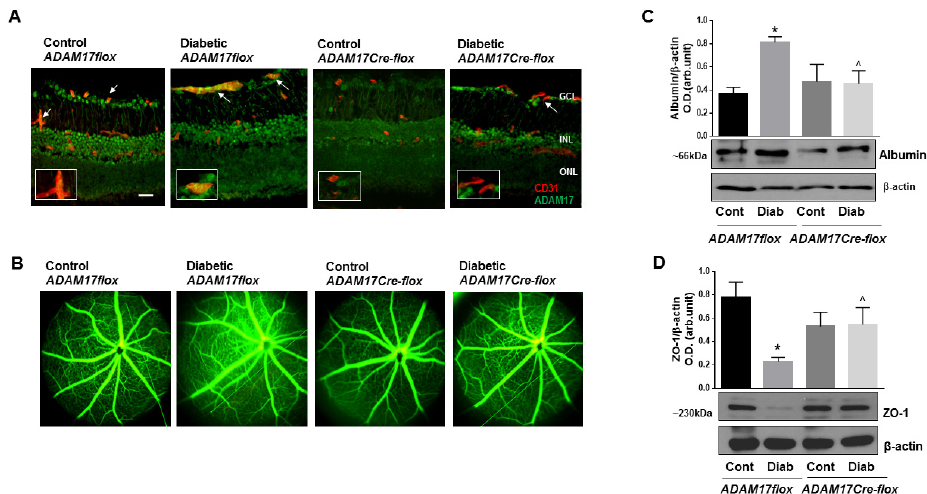
Figure 3. Diabetes-induced retinal vascular leakage is reduced in mice with conditional inactivation of ADAM17 in vascular endothelium. ( A ) Representative images of ADAM17-specific immunoreactivity (green, ADAM17; red, CD31; yellow, merging, white arrows) in retinal cryosections of normoglycemic and diabetic ADAM17Cre-flox and ADAM17flox mice at 10 weeks of diabetes. Inserts are magnified images of representative blood vessels. Scale bar, 50 µ m. ( B ) Fluorescein angiography from control normoglycemic and diabetic ADAM17flox and ADAM17Cre-flox mice. n = 5 in each group. ( C ) Western blot analysis assessing albumin protein levels in retinal extracts of perfused mice from control normoglycemic and diabetic ADAM17flox and ADAM17Cre-flox mice. Data presented as mean ± SE. * p < 0.01 diabetic vs. control. ˆ p < 0.05 diabetic ADAM17flox vs. diabetic ADAM17Cre-flox mice. n = 5 in each group. ( D ) Representative blots and densitometry analysis of ZO-1 expression from control normoglycemic and diabetic ADAM17flox and ADAM17Cre-flox mice. Data presented as mean ± SE. * p < 0.01 diabetic vs. control. ˆ p < 0.05 diabetic ADAM17flox vs. diabetic ADAM17Cre-flox mice. Cont, control; Diab, diabetic. n = 5 per group.